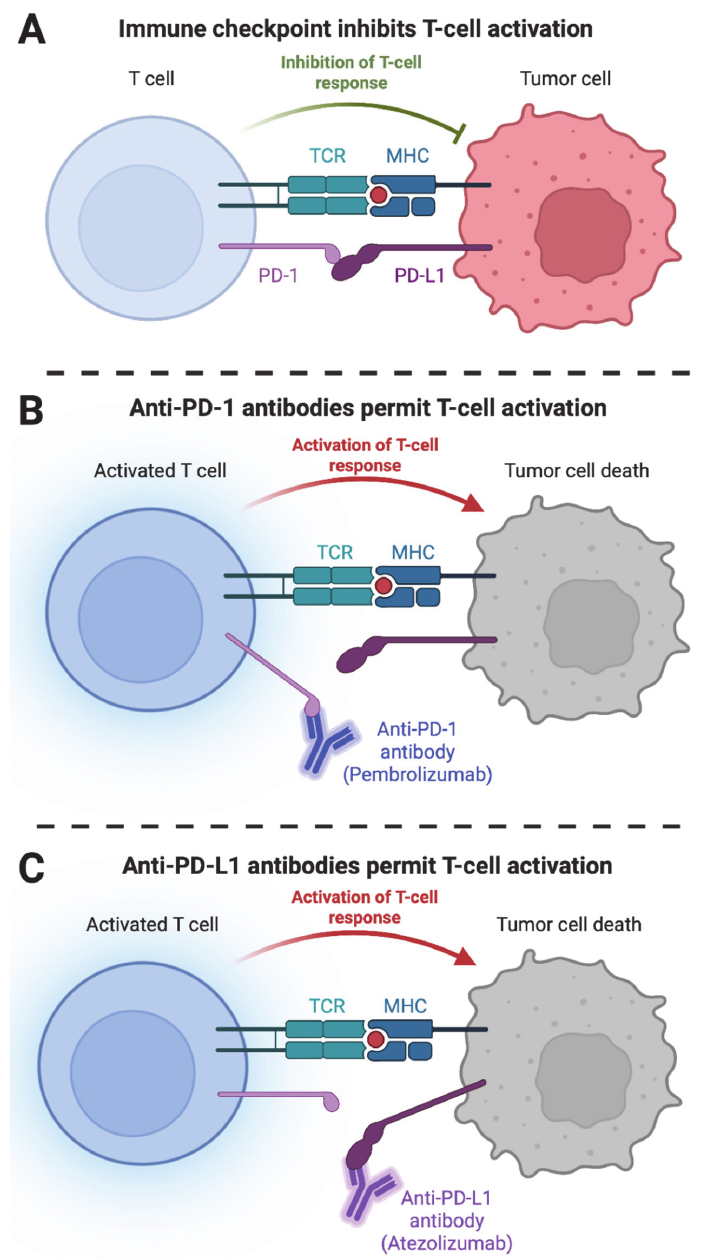
Figure 1. PD-1/PD-L1 function and targets. ( A ) Immune checkpoint inhibits T-cell activation and prevents tumor cell death. ( B ) Anti-PD-1 and ( C ) anti-PD-L1 antibodies (also known as immune checkpoint inhibitors) activate T-cell response and cause tumor death .